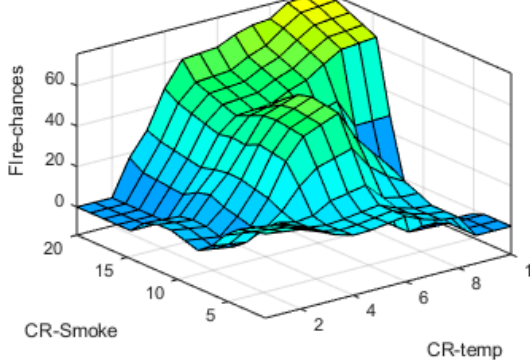
Figure 20. Time vs. CR-Temp surface plot.